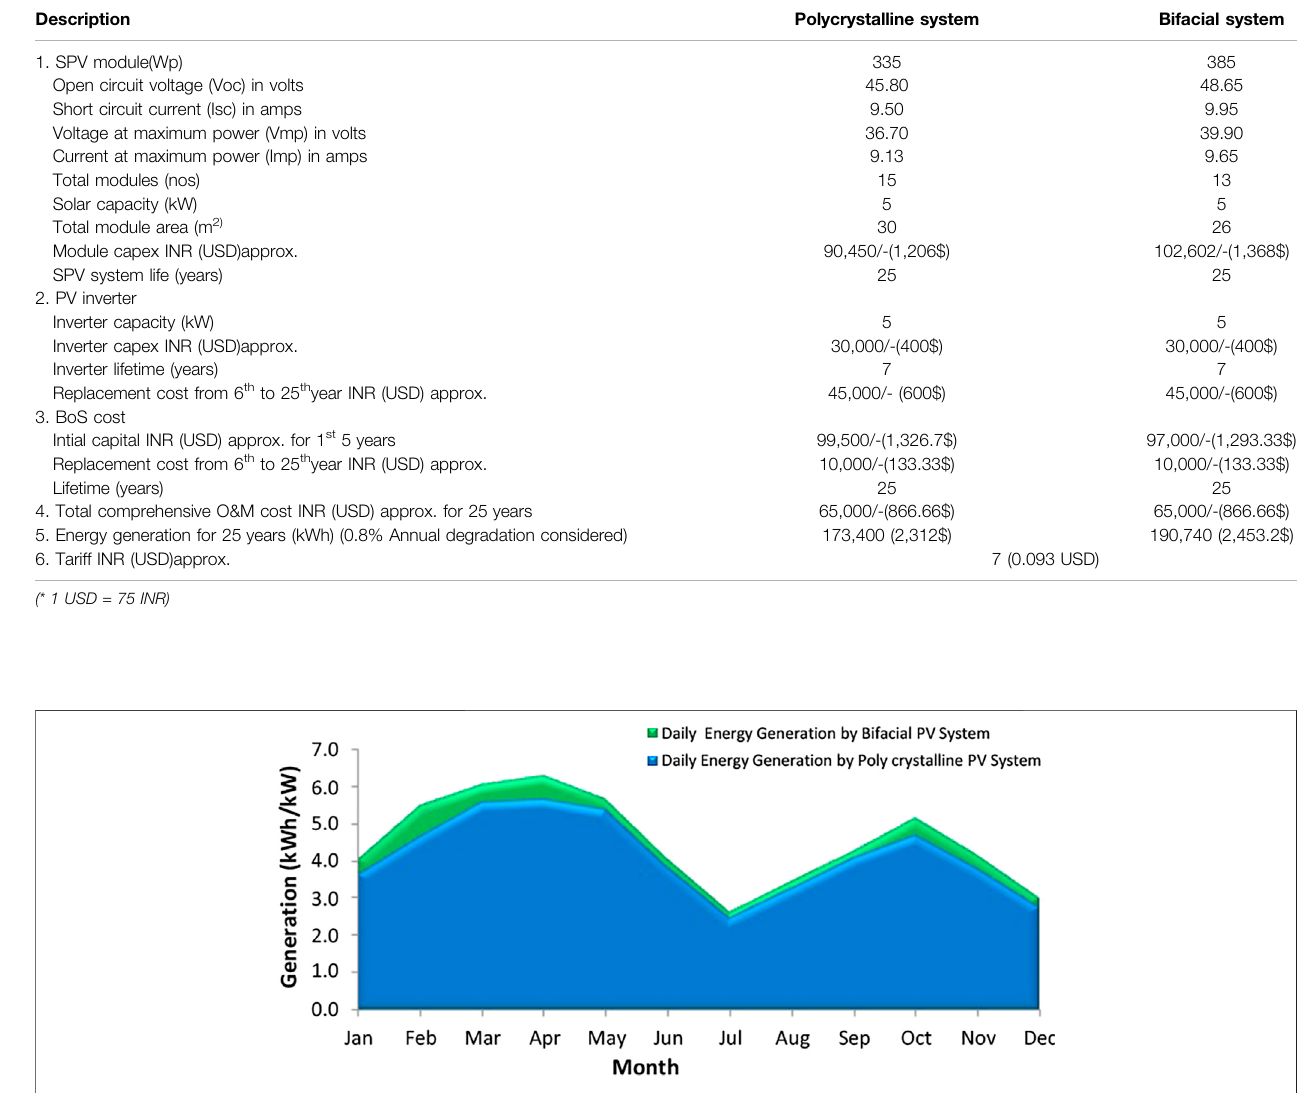
FIGURE 1 | Solar PV rooftop system daily